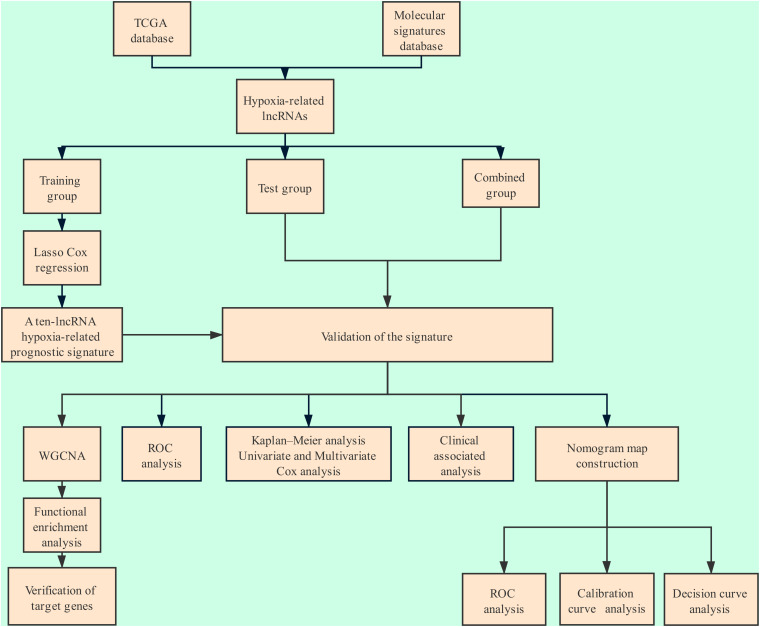
Flowchart of the analysis.